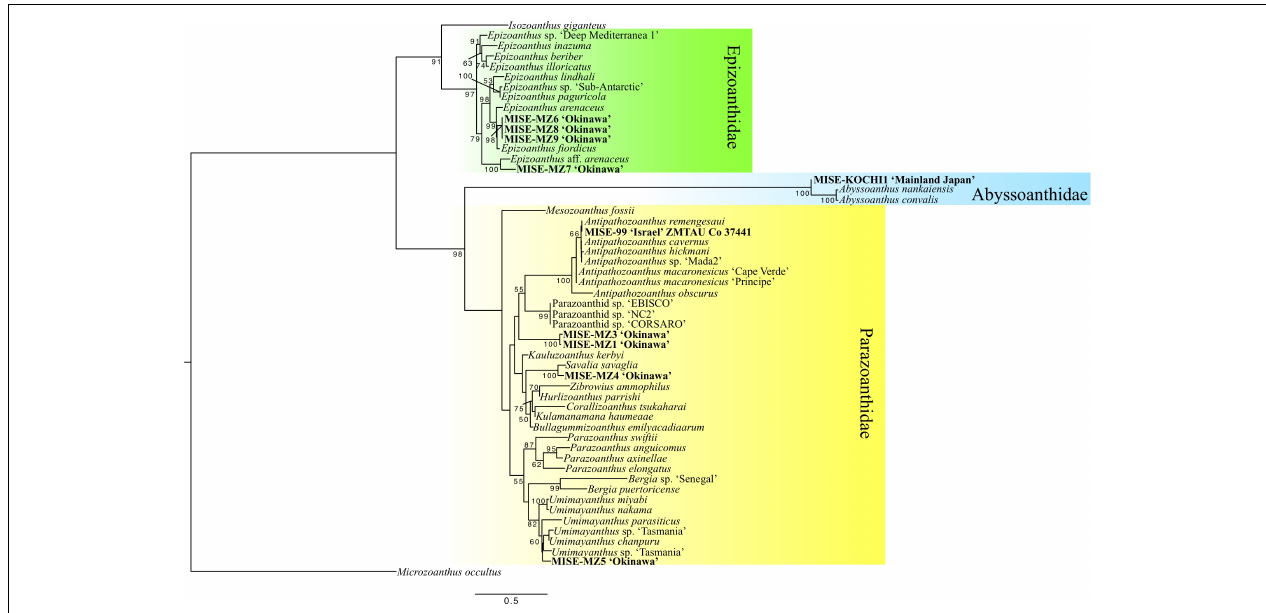
FIGURE 4 | Maximum likelihood (ML) phylogenetic tree of zoantharians including specimens newly collected in this study (in bold). Numbers at nodes represent bootstrap support